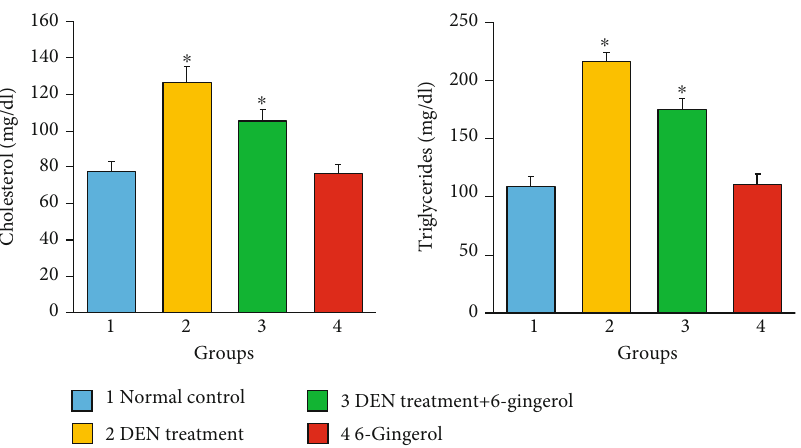
Figure 7: DEN induction caused signi fi cant increase in serum lipids including cholesterol and triglycerides as compared to the control. The coadministration of 6-gingerol with DEN showed a signi fi cant change as compared to the DEN-treated group ( p < 0 : 05